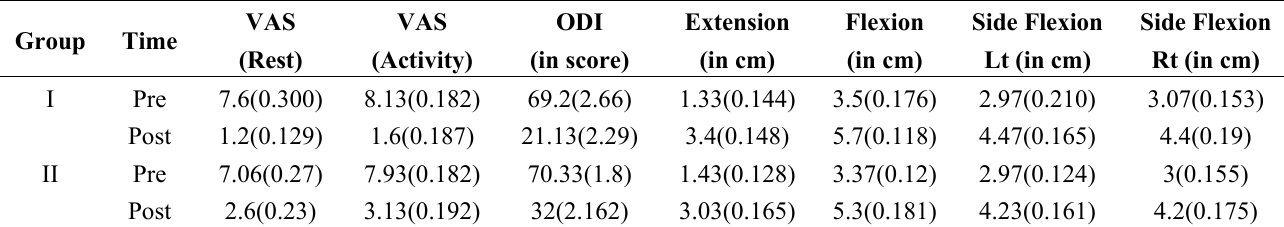
Table 1. Mean (SEM) values of outcome variables.